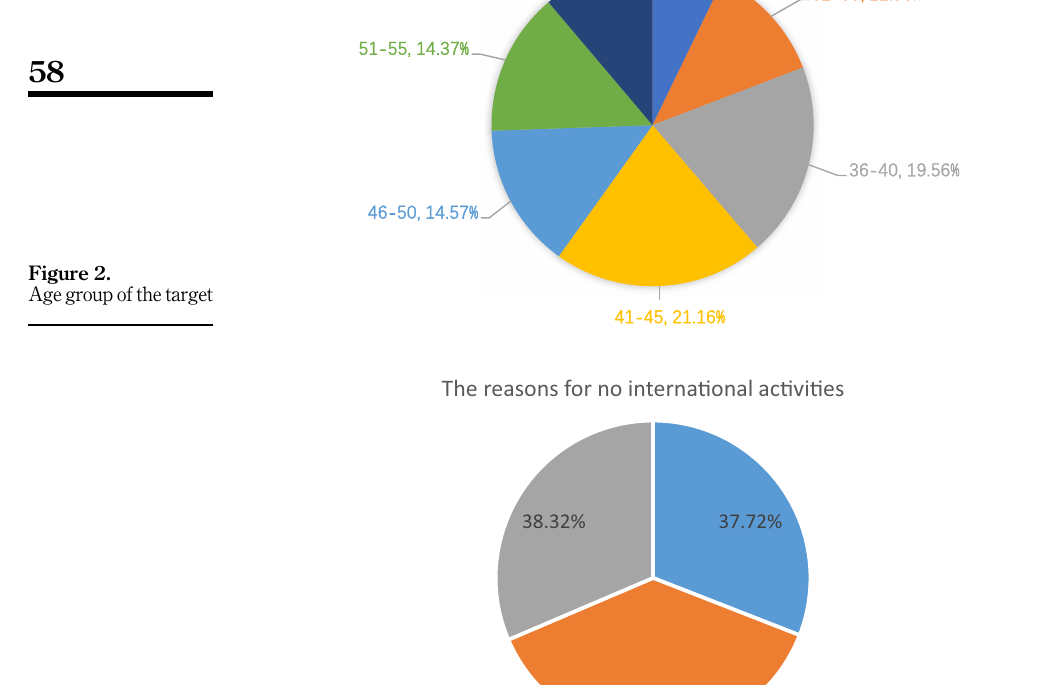
Figure 3. The reasons for